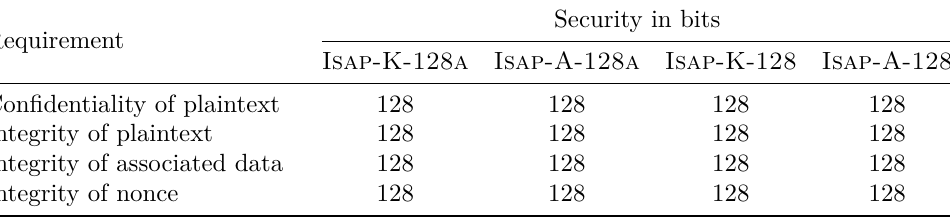
Table 3: Security claims for recommended parameter configurations of Isap